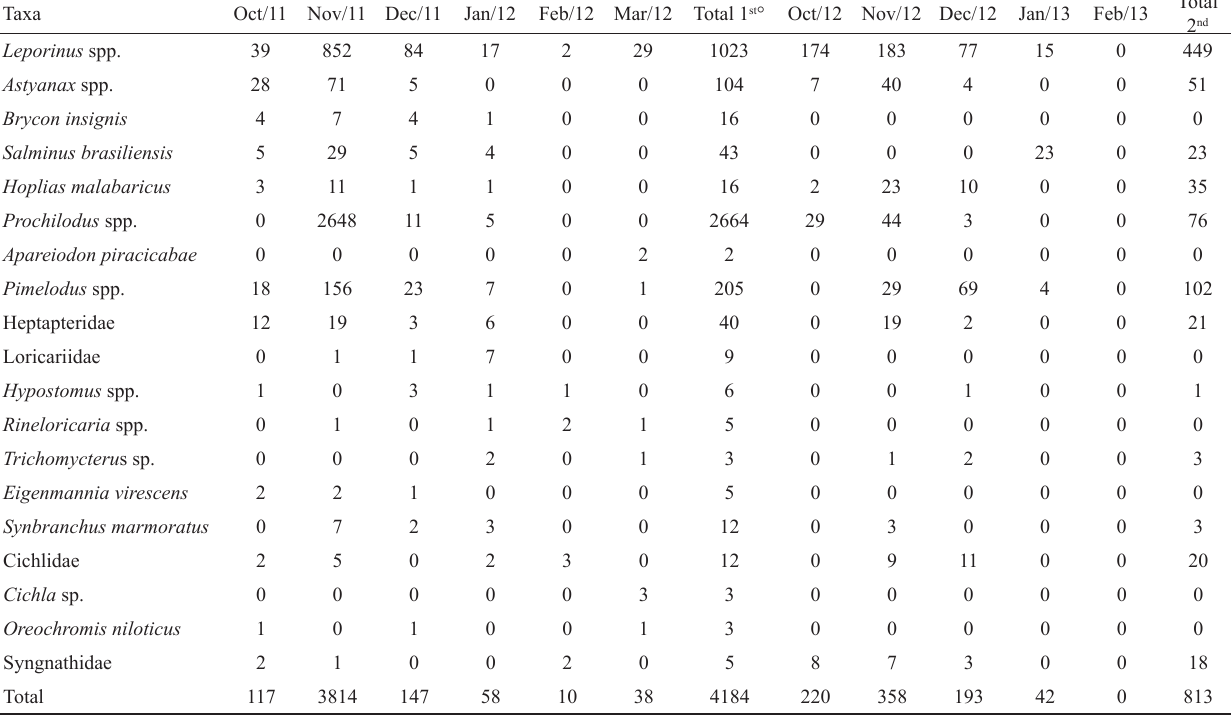
Tab. 3. Abundance of fish larvae per taxon during two reproductive cycles in the lower Paraíba do Sul River, Rio de Janeiro. The total abundances of larvae in the first and second reproductive periods of fishes in the Paraíba do Sul River are also